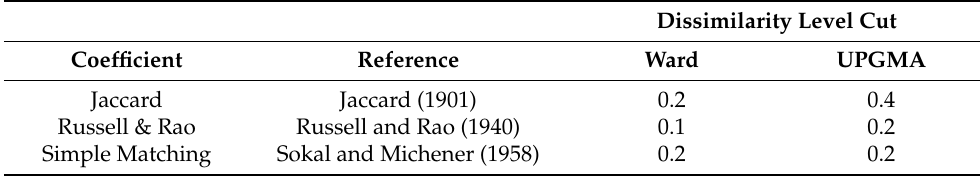
Table 1. Different dissimilarity algorithms used in the study.